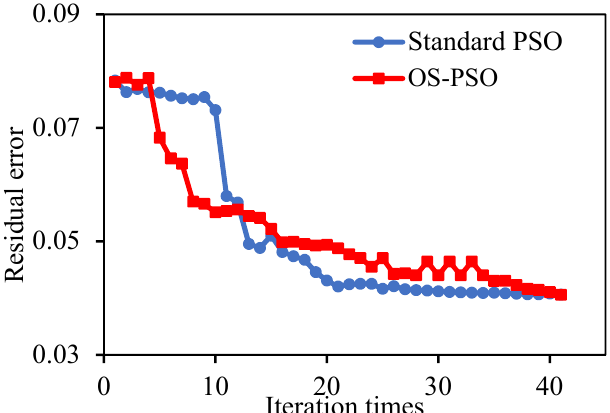
Figure 8. Residual error evolution for standard PSO and OS-PSO.